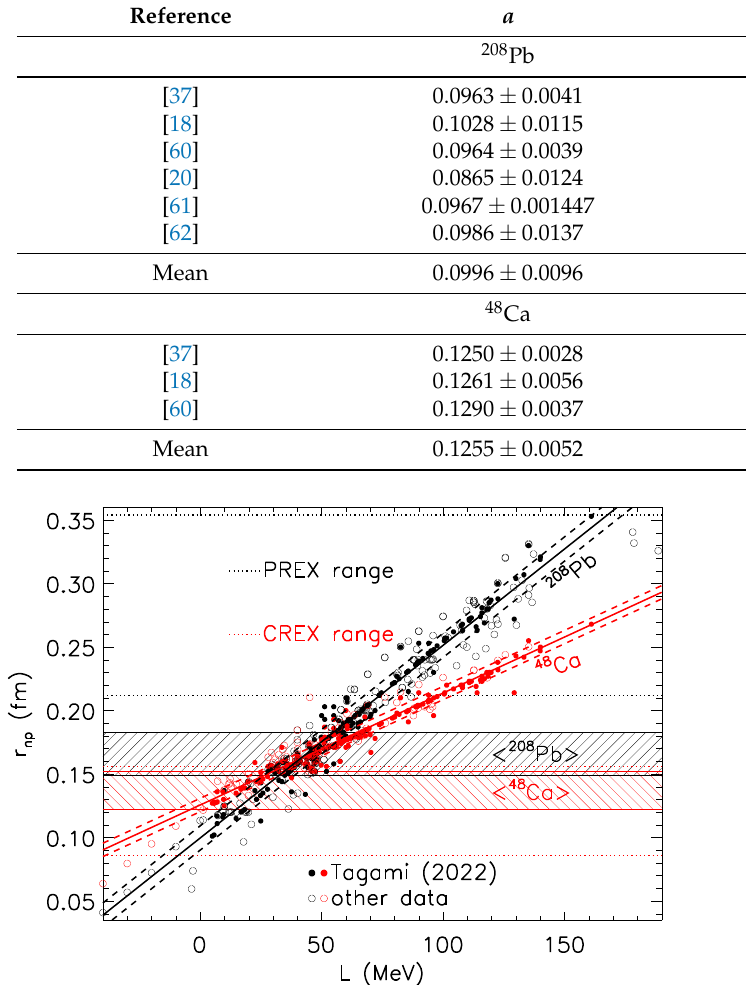
Figure 7. Neutron skin thicknesses of 48 Ca (red) and 208 Pb (black) from interactions compiled in Ref. [37] (filled circles) and Refs. [18,60,63,64] (open circles). Means (1 standard deviations) of linear correlations are shown as solid (dashed) lines. The horizontal shaded bands indicate the 1 standard deviation ranges of the averaged experimental results. The dotted black (red) lines indicate the 1 standard deviation range of r 208 np ( r 48 np ) from PREX I+II [17] (CREX